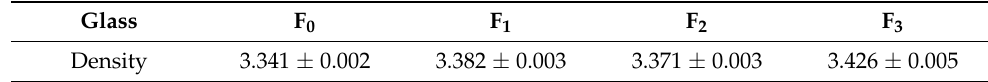
Table 3. Density of F 0 , F 1 , F 2 , and F 3 glasses.